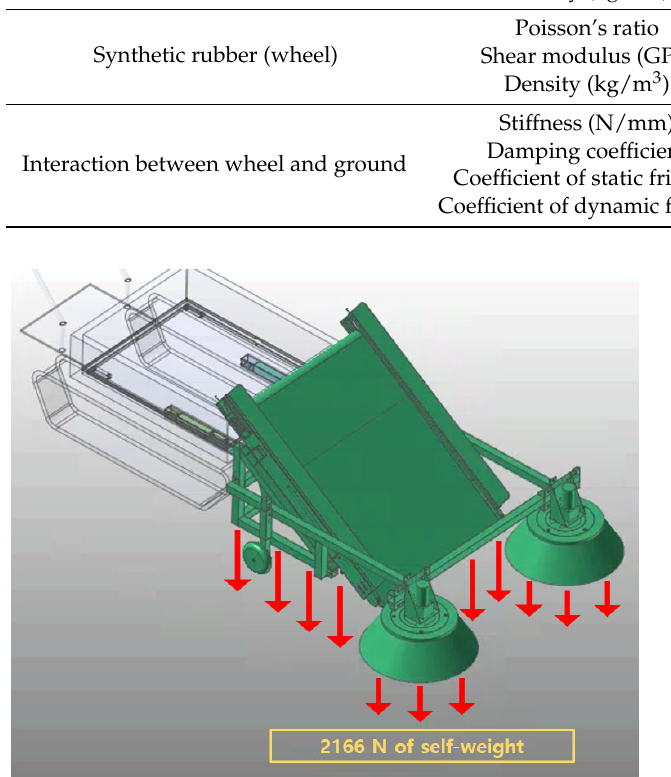
Figure 3. 3D modeling of agricultural by-product collector.